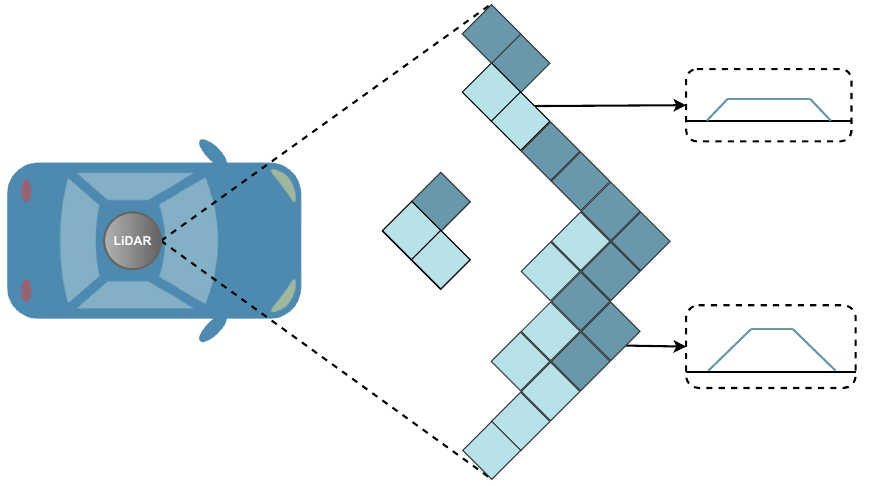
Figure 6. Visual representation of an Elevation